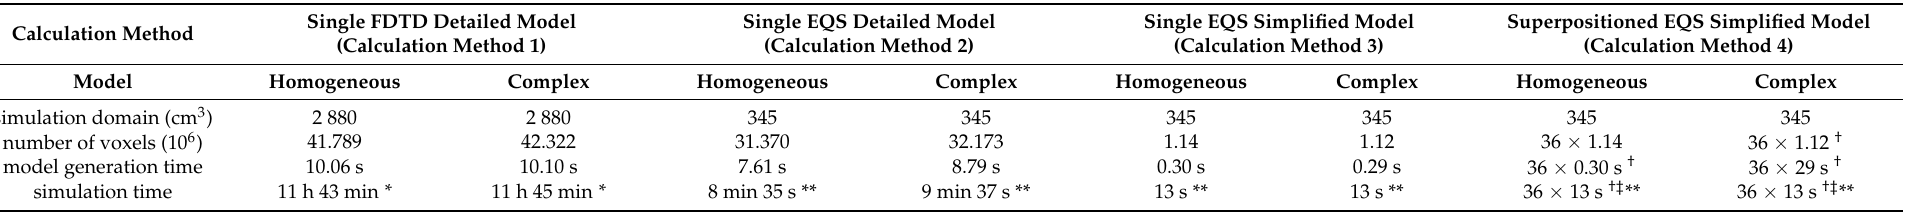
Table 3. Table summarizing the memory and time requirements of all evaluated calculation methods on the homogenous and complex benchmarking